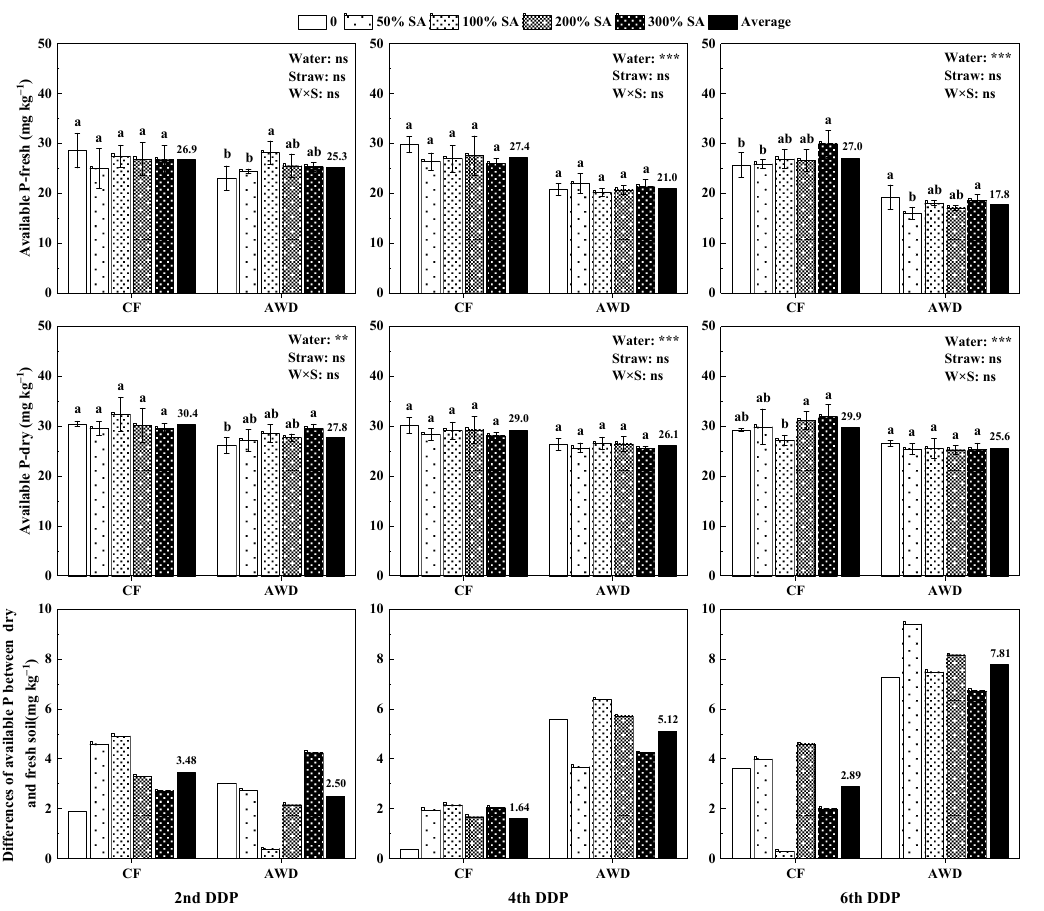
Figure 2. Fresh and air-dried soil available P content and differences of available P content between air-dried soil and fresh soil under different water management regimes and straw addition rates. Different letters indicate significantly different at p < 0.05 under the same water management regime. Data in the figures indicate means of three replicates ± standard deviation. ** means p < 0.01; *** means p < 0.001; ns means non-significant. CF, continuous flooding irrigation; AWD, alternate wetting and drying irrigation; SA, straw addition rate. DDP, day of the drying period.